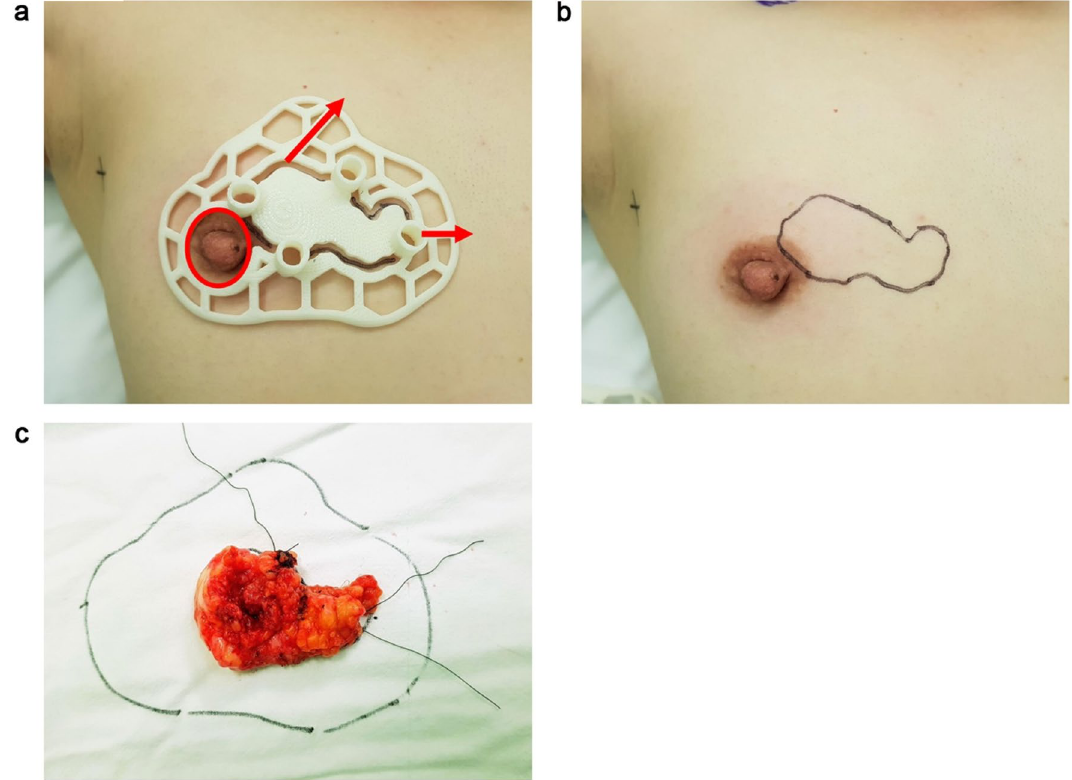
Figure 2. Partial breast excision by applying a breast surgical guide (BSG). ( a ) To accurately localize the tumor, fix the BSG based on both nipples and the suprasternal notch, ( b ) Quantitatively mark the area of the tumor